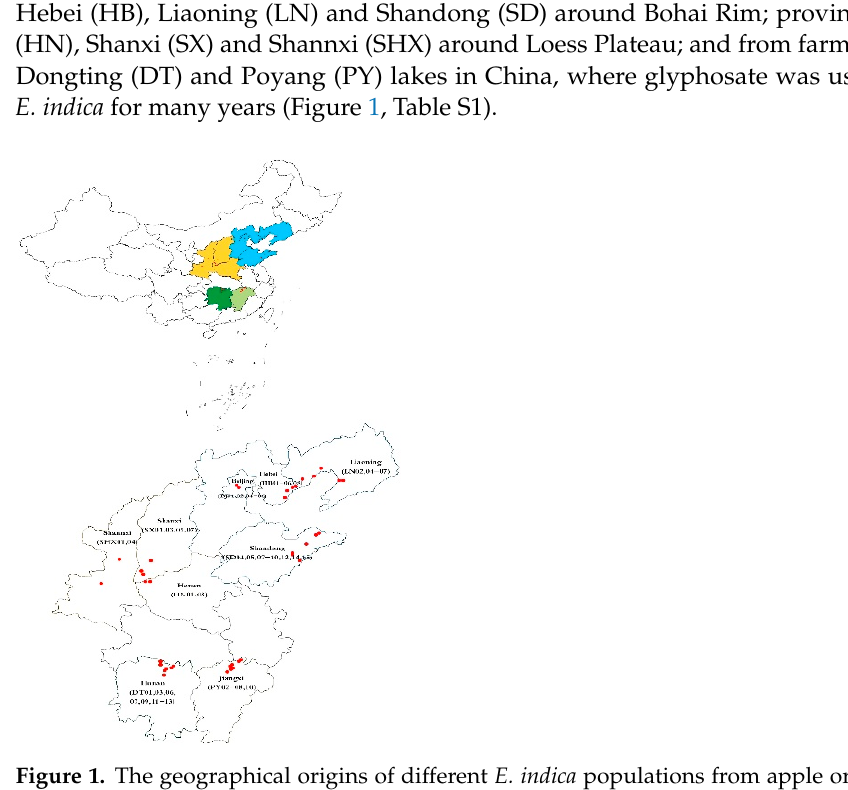
The shikimic acid was measured using the leaf disc method described by Mei et al. (2018) [11]. First, the Petri dish was filled with 5 mL NaH 2 PO 4 solution (pH 4.4) containing 1.0, 10 or 100 mg/L glyphosate. Next, two leaves with a length of 5 mm were cut from each of the five E. indica plants and immersed into glyphosate solutions. The Petri dishes were transferred into an artificial climate chamber for 16 h under the conditions of 25 °C, con- tinuous 16 h illumination. All leaves were ground in liquid nitrogen, and then 1 mL of 1.25 M HCl was added to extract the shikimate. Finally, the samples were incubated at 37 °C with agitation for 30 min after mixing vigorously for 5 min, and then centrifuged at 12,000 g for 10 min. The supernatants were collected and used for shikimic acid determi- nation. The reaction mixtures were incubated at 37 °C for 60 min, which contained 250 µL supernatants, 1.0 mL 0.25% ( w / v ) periodic acid and 0.25% ( w / v ) sodium metaperiodate. The reaction was stopped by adding 1 mL 0.6 M NaOH and 0.22 M Na 2 SO 3 . The optical density (OD) at 383 nm was determined colorimetrically using microplate photometer (BioTek, Vermont, USA). Six replicates were set for each glyphosate concentration. The shikimic acid concentration was calculated based on a standard curve. The experiments were repeated four times with independent extracts. The shikimic acid concentration was expressed in µg cm − 2 leaves. 2.4. RNA Extraction and cDNA Synthesis Pooled samples of six plants at the stage of 6-leaf were used for RNA extraction. Total RNA was extracted according to the instruction of RNApre Pure Plant Kits (Tiangen, Bei- jing, China). First-strand cDNA was reverse-transcribed using 2µg total RNA (Tiangen, Beijing, China). The cDNA was synthesized in a 25 µL reaction mixture, which included 1µL cDNA, 0.5 µL primer pairs, 12.5 µL 2 × PCR Mix and 10.5µL ddH 2 O. The primer pairs ( 5 ′ -GGTGGATAACCTTTTAAACAGTGAG-3 ′ and 5 ′ -TTAGTTCTTGACGAAAGTGCTGAG-3 ′ ) were designed according the EPSPS sequence of E. indica (HQ403647). The PCR programs consisted of one denaturation step of 3 min at 94 °C, 30 cycles of 30 s at 94 °C, 30 s at 56 °C, 72 °C for 30 s, followed by a final extension step of 5 min at 72 °C.